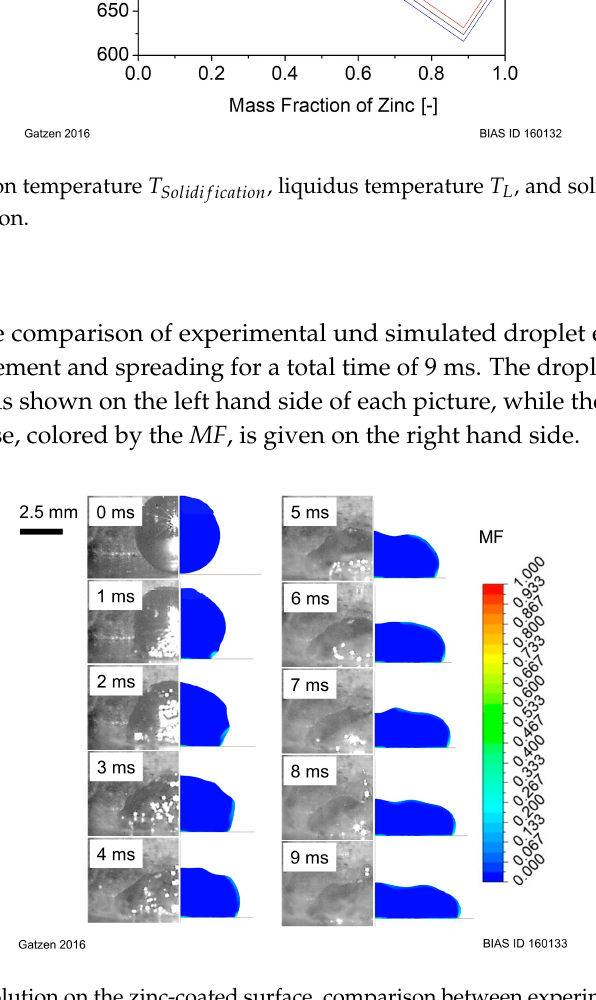
Figure 3. Droplet evolution on the zinc-coated surface, comparison between experiment and simulation.